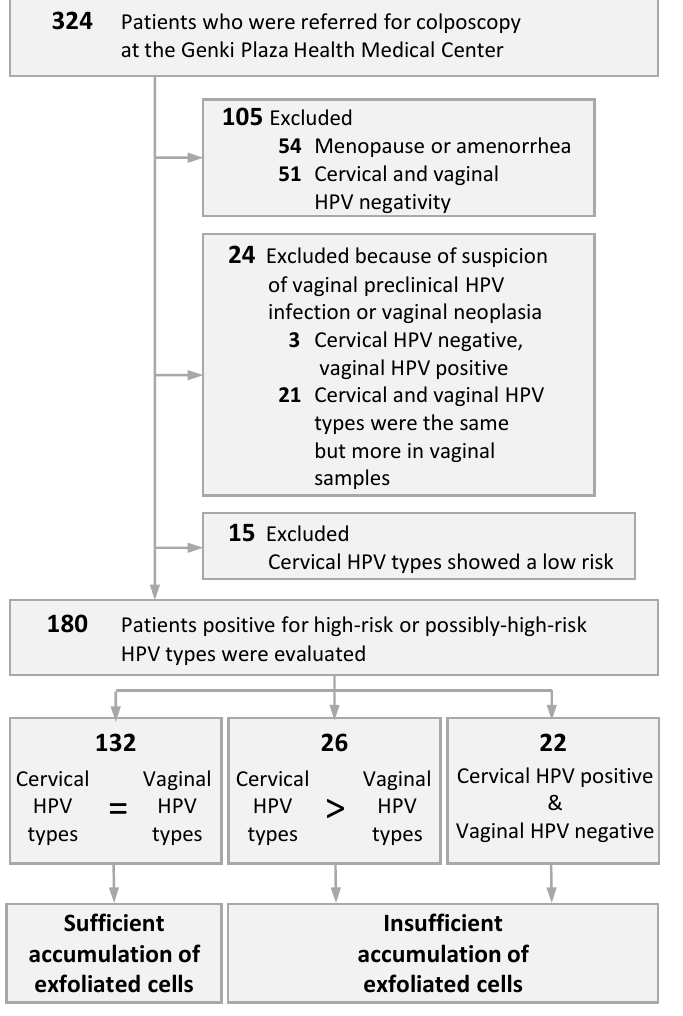
Figure 1. Stratification of patients by the accumulation of exfoliated cells during the menstrual cycle. HPV, human papillomavirus.